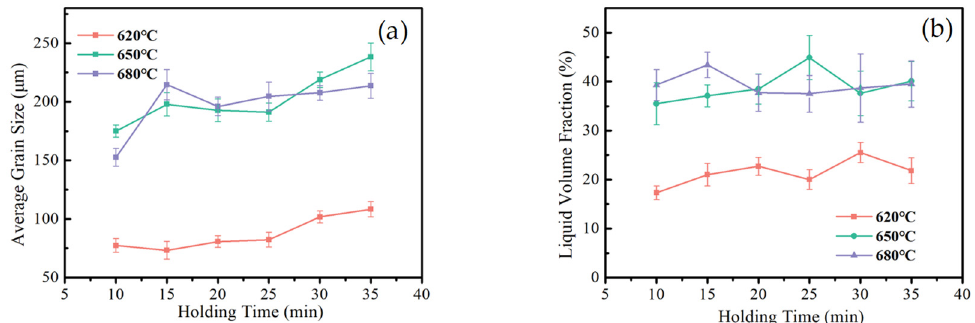
Figure 6. Quantitative analysis of microstructure at different holding times; ( a ) average grain size, and ( b ) liquid volume fraction.